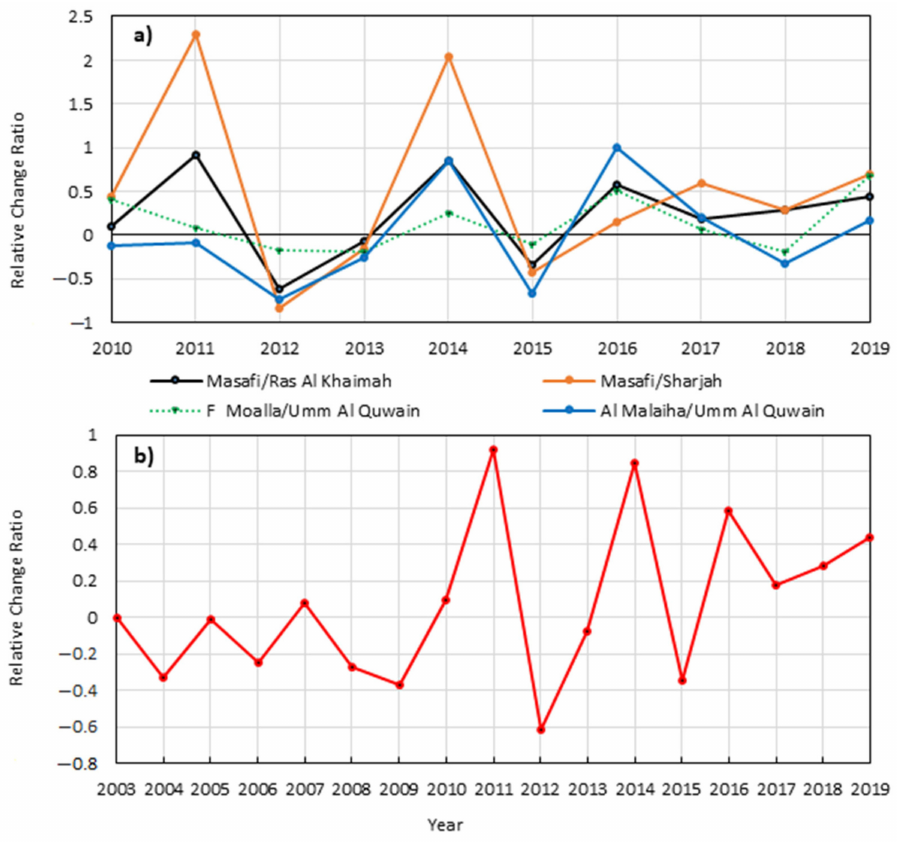
Figure 4. Time series of inter-annual variation in the rainfall relative change ratio for ( a ) individ- ual target gauges during 2010–2019 and for ( b ) the overall target area from Equation (11) during